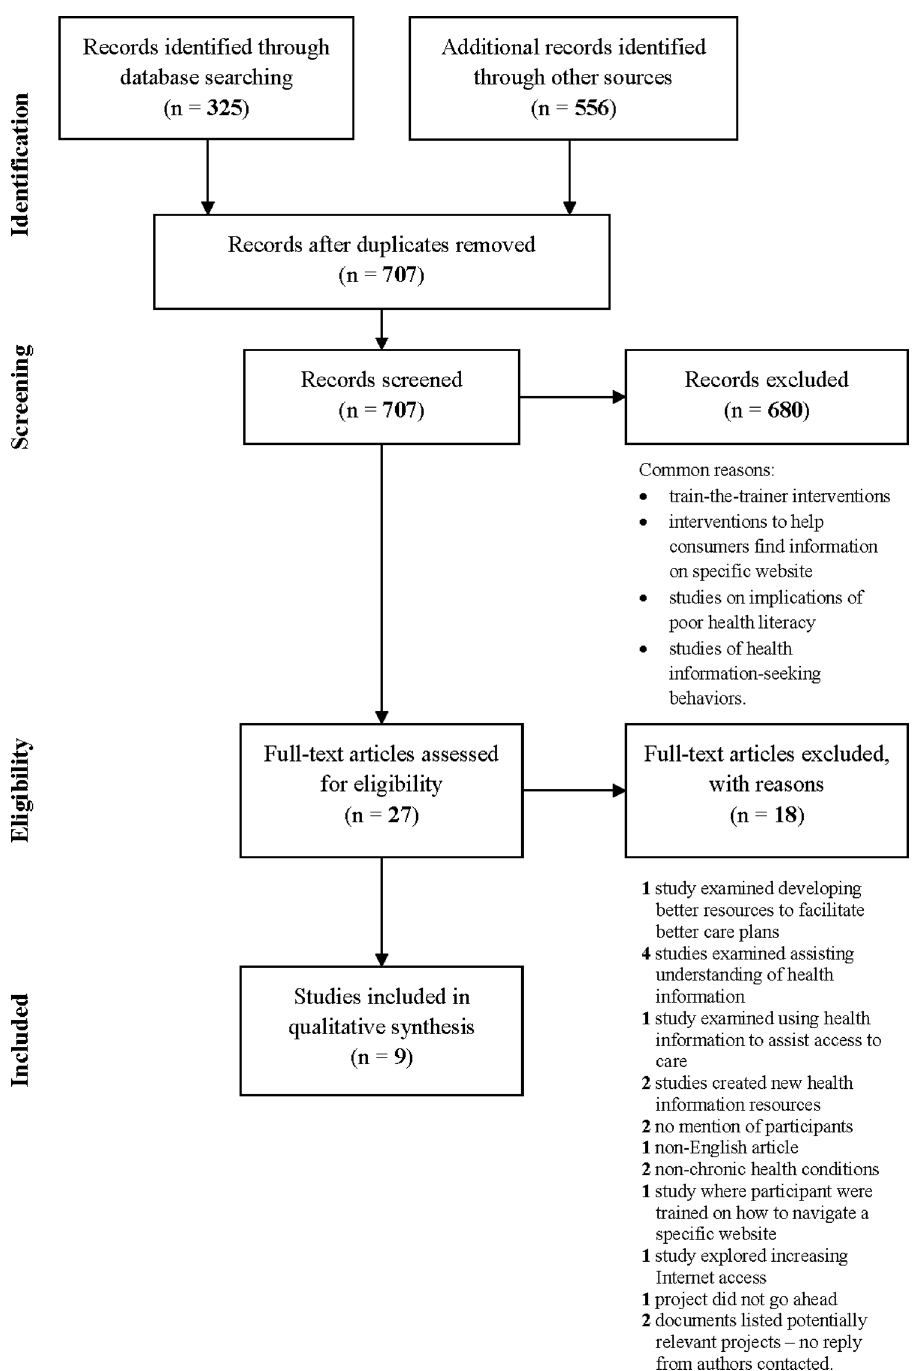
Figure 1. Applies principles of the PRISMA Flow diagram template and outlines the process used to identify, screen, select, and analyse studies for this comprehensive review.